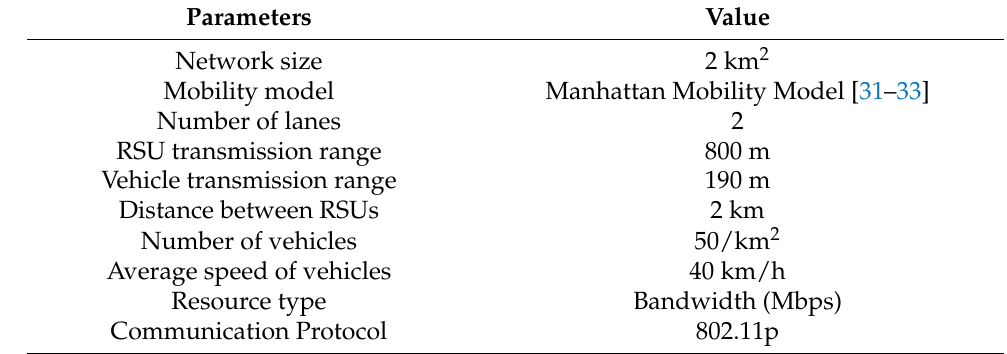
Table 2. Simulation parameters